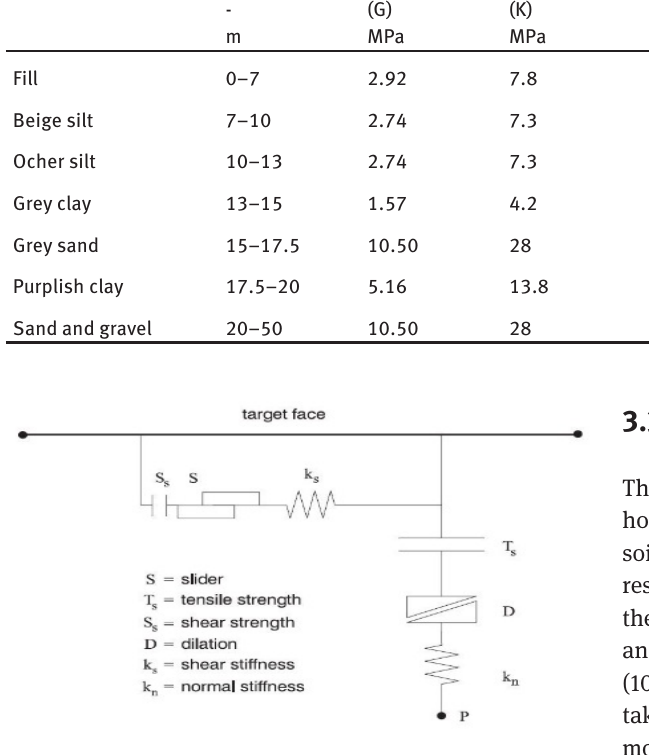
Figure 8: Components of the interface constitutive model.